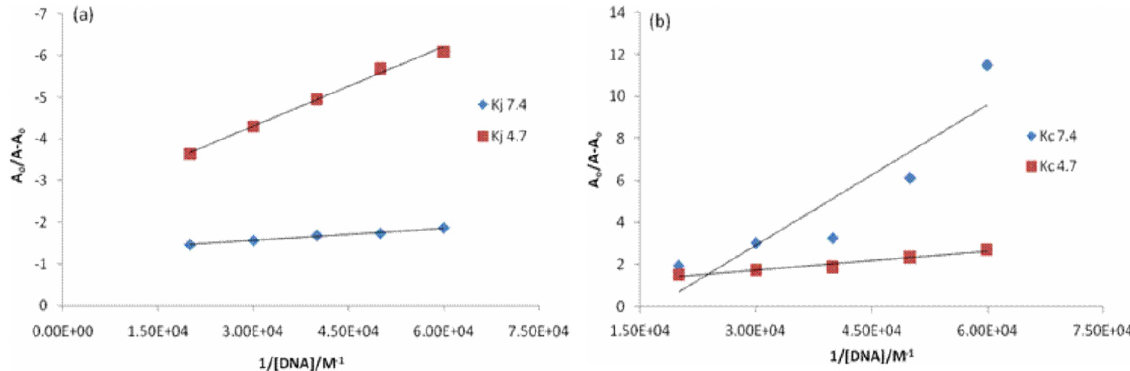
Figure 4. Plot of Benesi-Hildebrand equation for calculation of binding constant (Kb) of karanjin (a) and karanjachromene (b) at pH 7.4 and 4.7 and at 37ºC.